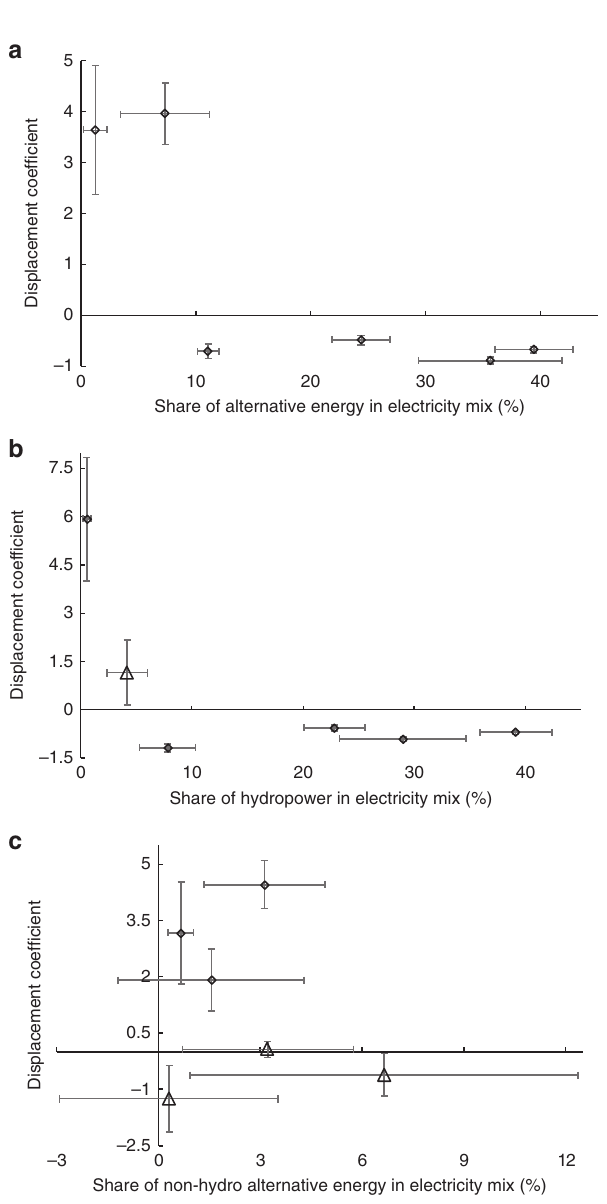
Figure 3 | Dependence of alternative energy’s displacement effect on its grid penetration. Shown are the displacement coefficients of ( a ) alternative energy, ( b ) hydropower and ( c ) non-hydro alternative energy for substituting fossil-fuel-generated electricity by local plants (within the provinces) as a function of its penetration in the electricity supply mix of China’s six inter-provincial regional power grids. Error bars represent s.e.m., and statistically significant and insignificant displacement coefficients (compared to 0, P value o 0.05, two-tailed test) are plotted with the symbols of ‘‘diamond’’ and ‘‘triangle’’,